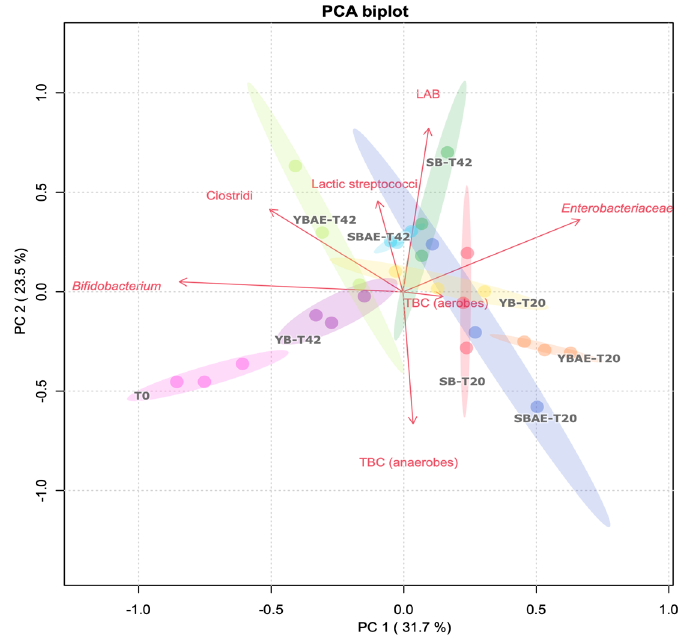
Figure 3. Biplot of the principal component analysis (PCA) of viable microbial cell densities in fermented fecal batches. Both score and loading plots are shown. The score plot shows fermented fecal batches different for the used bread digest (yeast bread, YB; yeast bread with artichoke extract, YB-AE; sourdough bread, SB; and sourdough bread with artichoke extract, SB-AE) and for the time of fermentation (20 and 42 h, T20 and T42, respectively). Based on normalized values, the loading plot shows the cell densities of the plated microbial groups. Clouds (weighted on the 95th percentile of the confidence interval of three replicates) have different colors for both digested bread and the time of fermentation. Cloud colors represent baseline (that is, the inoculum labeled as T0, pink), YB-T20 (yellow), YB-T42 (purple), YB-AE-T20 (orange), YB-AE-T42 (light green), SB-T20 (red), SB-T42 (green), SB-AE-T20 (blue), and SB-AE-T42 (light blue). Abbreviations: total bacterial count (TBC); lactic acid bacteria (LAB).